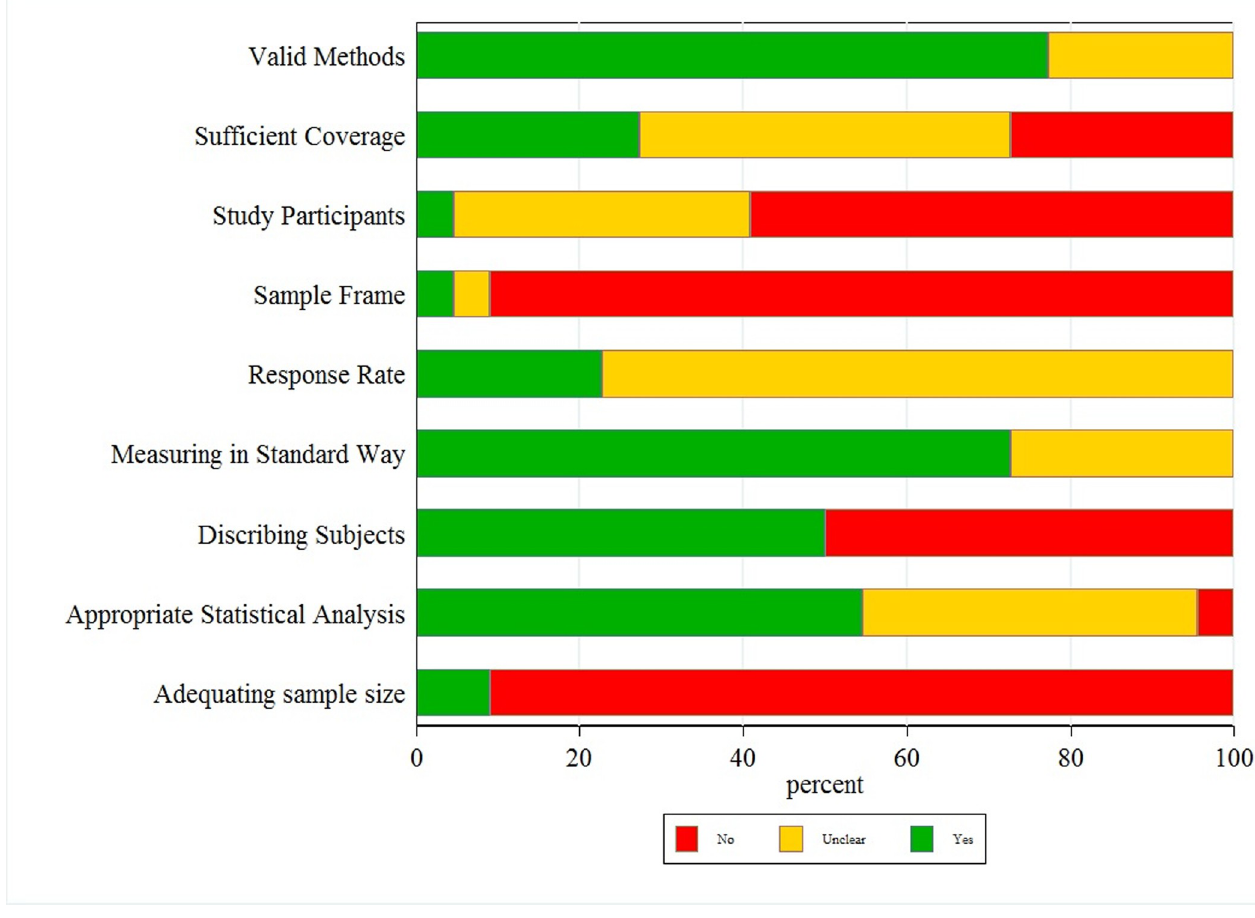
Fig 2. Quality assessment of the included studies based on the JBI